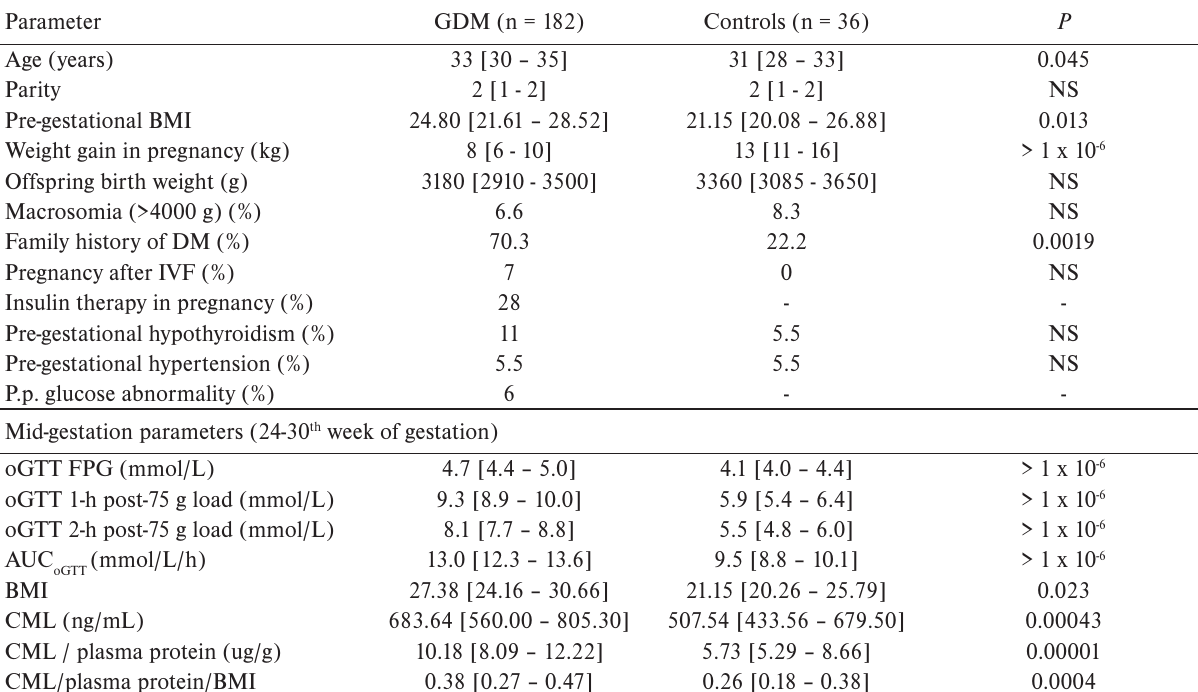
Table 1. Clinical, anthropometric and laboratory characteristics of the study groups.